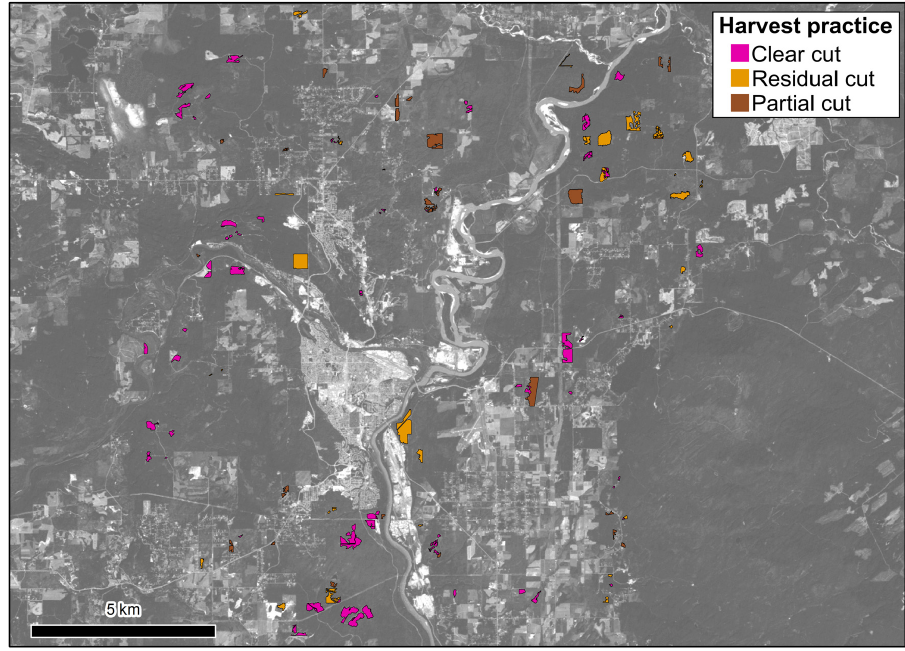
Figure 4. Reference forest harvest polygons compiled from a combination of ground site visits (on